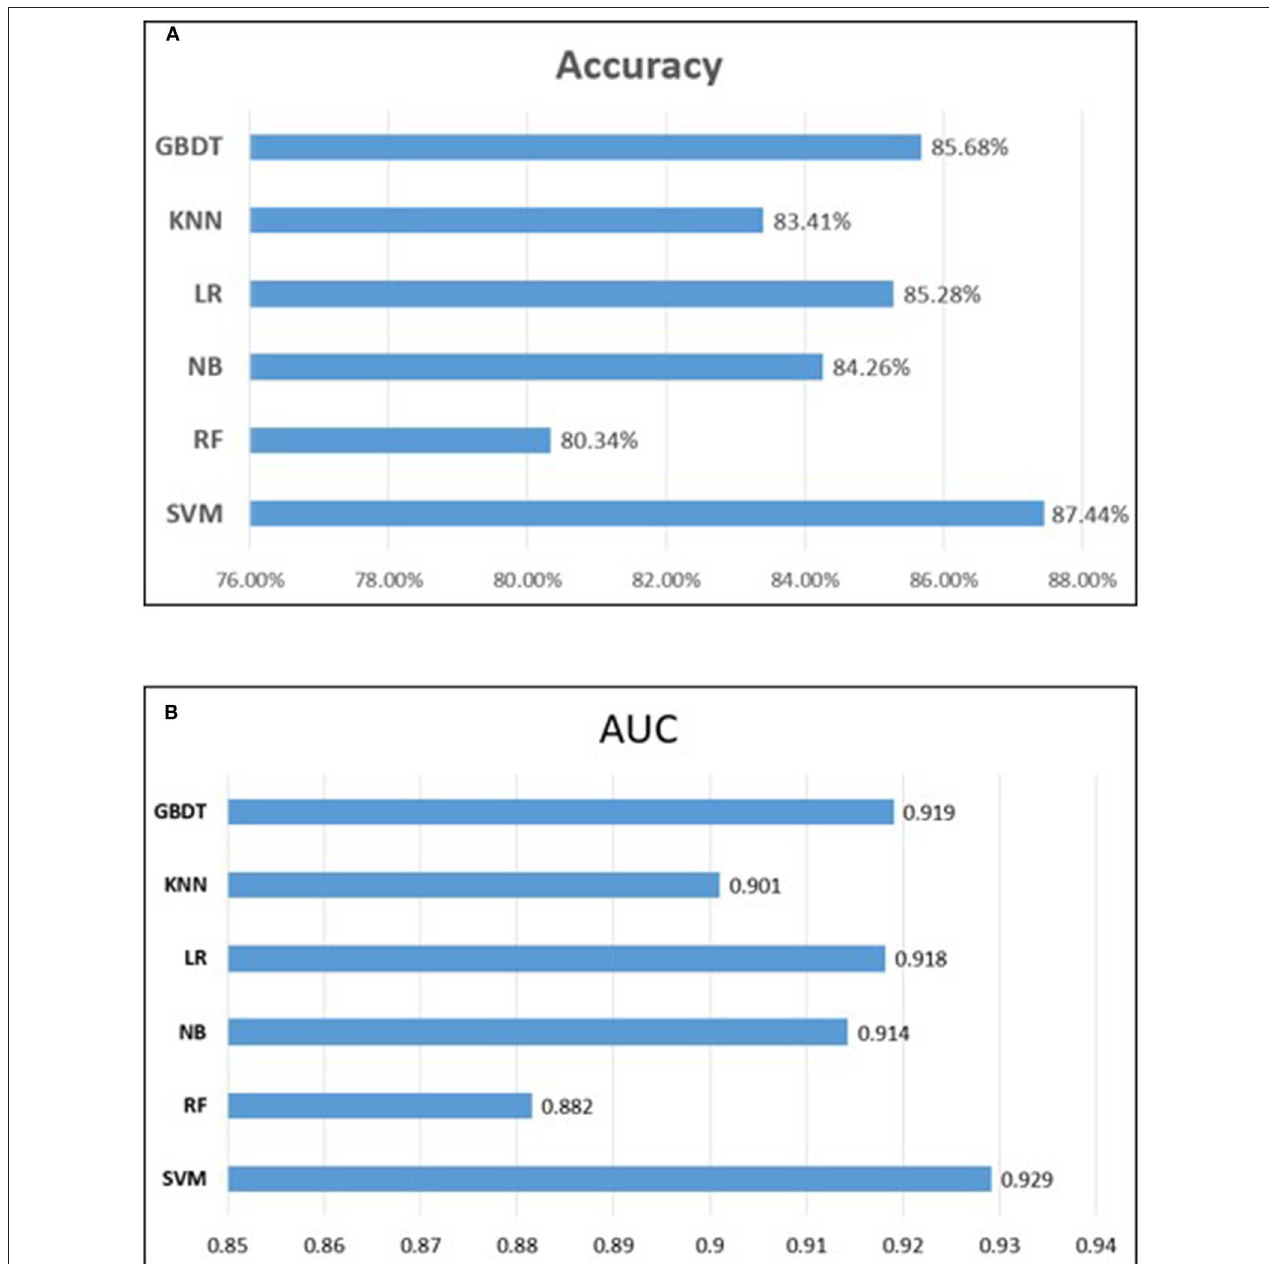
FIGURE 5 | Performance comparison of different classifiers. (A) represents the comparison results of prediction accuracy of six classifiers, and (B) represents the comparison results of